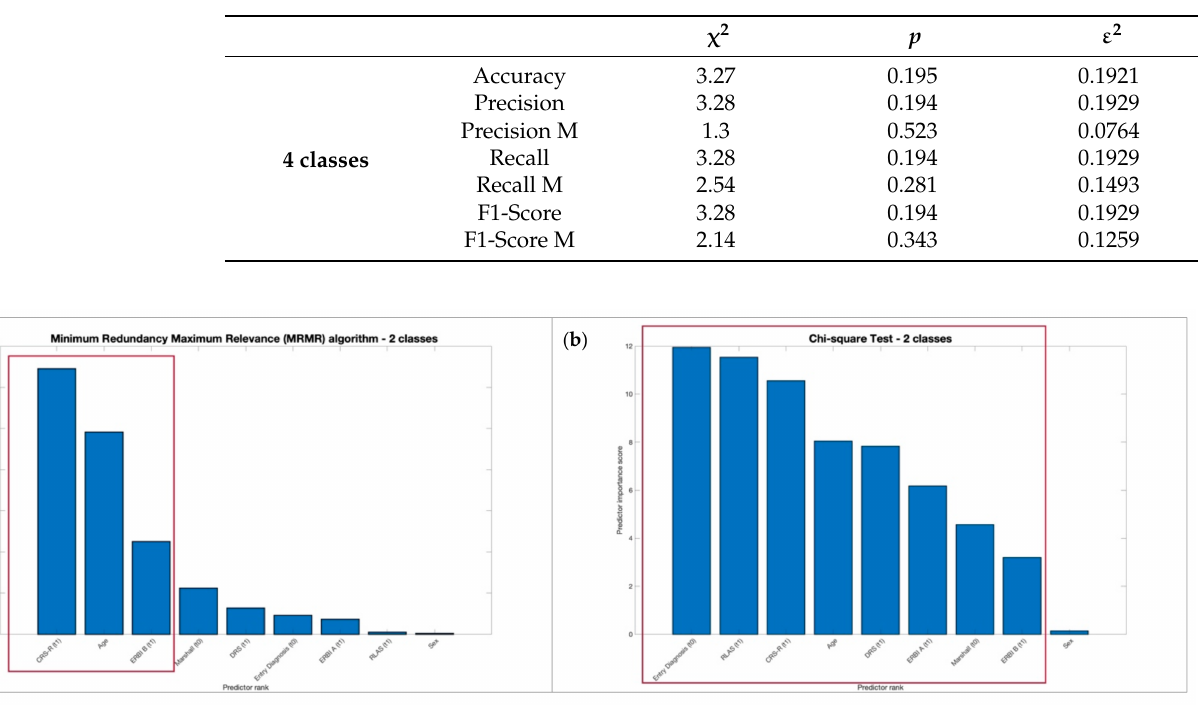
Figure 1. Most significant features selected using 2 classes of outcome, respectively, using MRMR and Chi-Square selection methods.